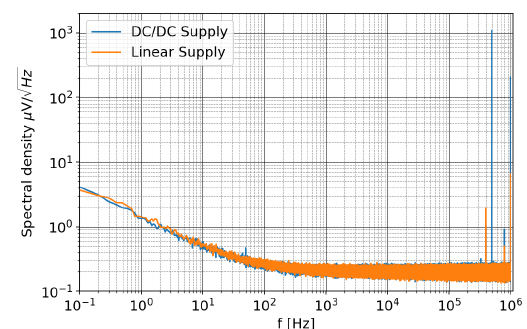
Figure 18. Noise spectral density for the AD7641 with two type of power supplies; the difference is in the level of harmonic associated to the DC/DC converter, while the 1/f noise appears